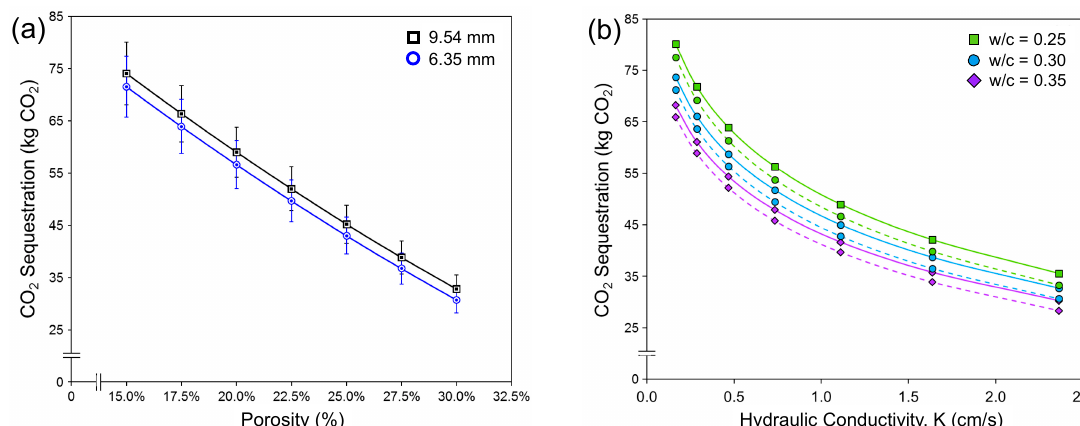
Figure 5. ( a ) Effect of design porosity on average CO 2 sequestration of 1 m 3 of pervious concrete. Means and error bars represent ± one standard deviation of CO 2 sequestration potential from fixed-porosity mixtures designed using water-to-cement (w/c) ratios of 0.25, 0.30, and 0.35. Aggregate size is differentiated by color. ( b ) Effect of design hydraulic conductivity on average CO 2 sequestration potential of a 1 m 3 of pervious concrete, with varying w/c ratios and both 9.35 mm (—) and 6.35 mm (- - -) aggregate.